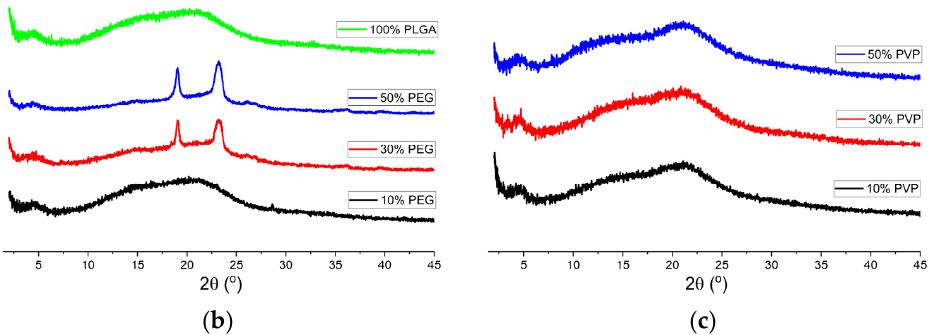
Figure 2. XRD patterns of ( a ) raw materials (PLGA, PEG, PVP, and KGN); ( b ) PLGA and PLGA/PEG particles loaded with KGN; and ( c ) PLGA/PVP particles loaded with KGN.